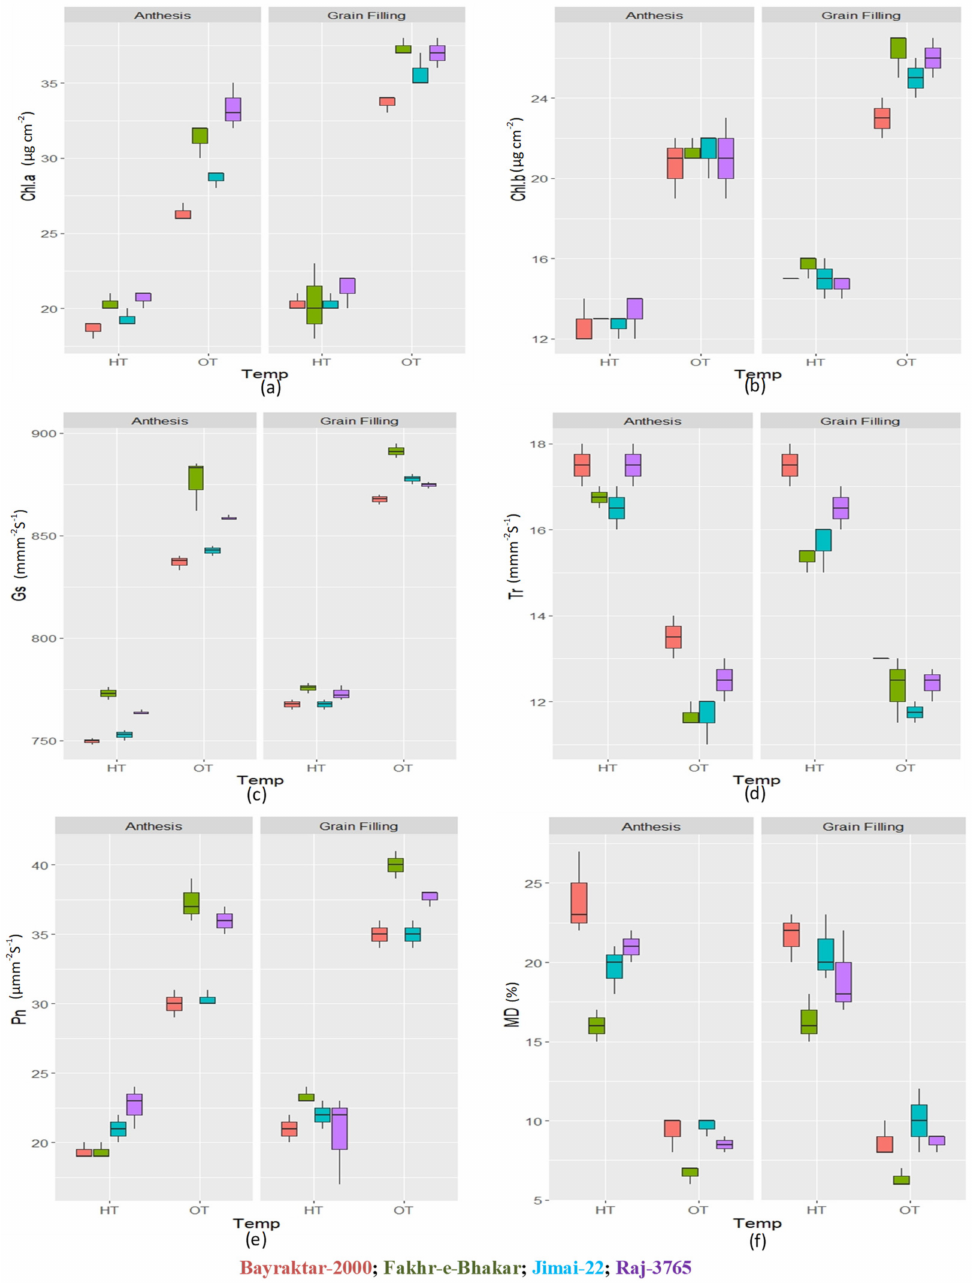
Figure 3. Effect of different regimes of temperature: optimum temperature (OT); high temperature (HT) on different physiological parameters of wheat genotypes during grain-filling and anthesis stage: ( a ). Chl-a; ( b ). Chl-b; ( c ). Gs, Stomatal conductance; ( d ) Tr, transpiration rate; ( e ). Pn, photosynthesis rate; ( f ) MD, membrane damage. Values shown are mean estimates averaged on 3, 5, 7, 9, 11 and 13 days of temperature treatment impositions during tri-replicate experiment at p ≤